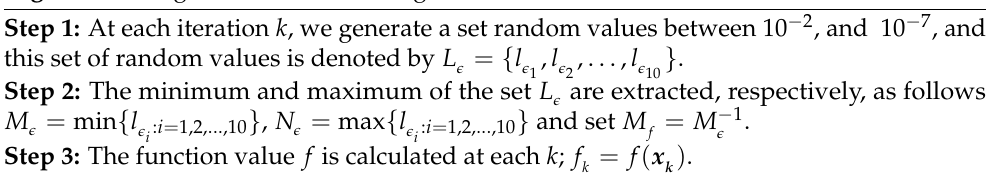
Algorithm 2 Algorithm for calculating the values of h ∗